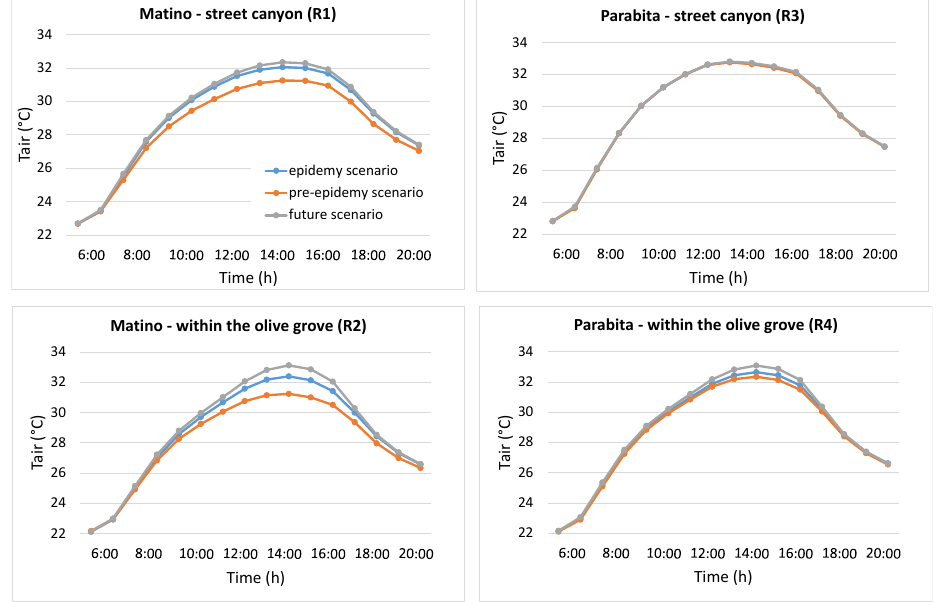
Figure 6. Air temperature hourly profiles for Matino (left) and Parabita (right) inside the street canyon (top) and within the olive grove (bottom) (see Figure 3 for the position of receptors R1, R2, R3 and R4).